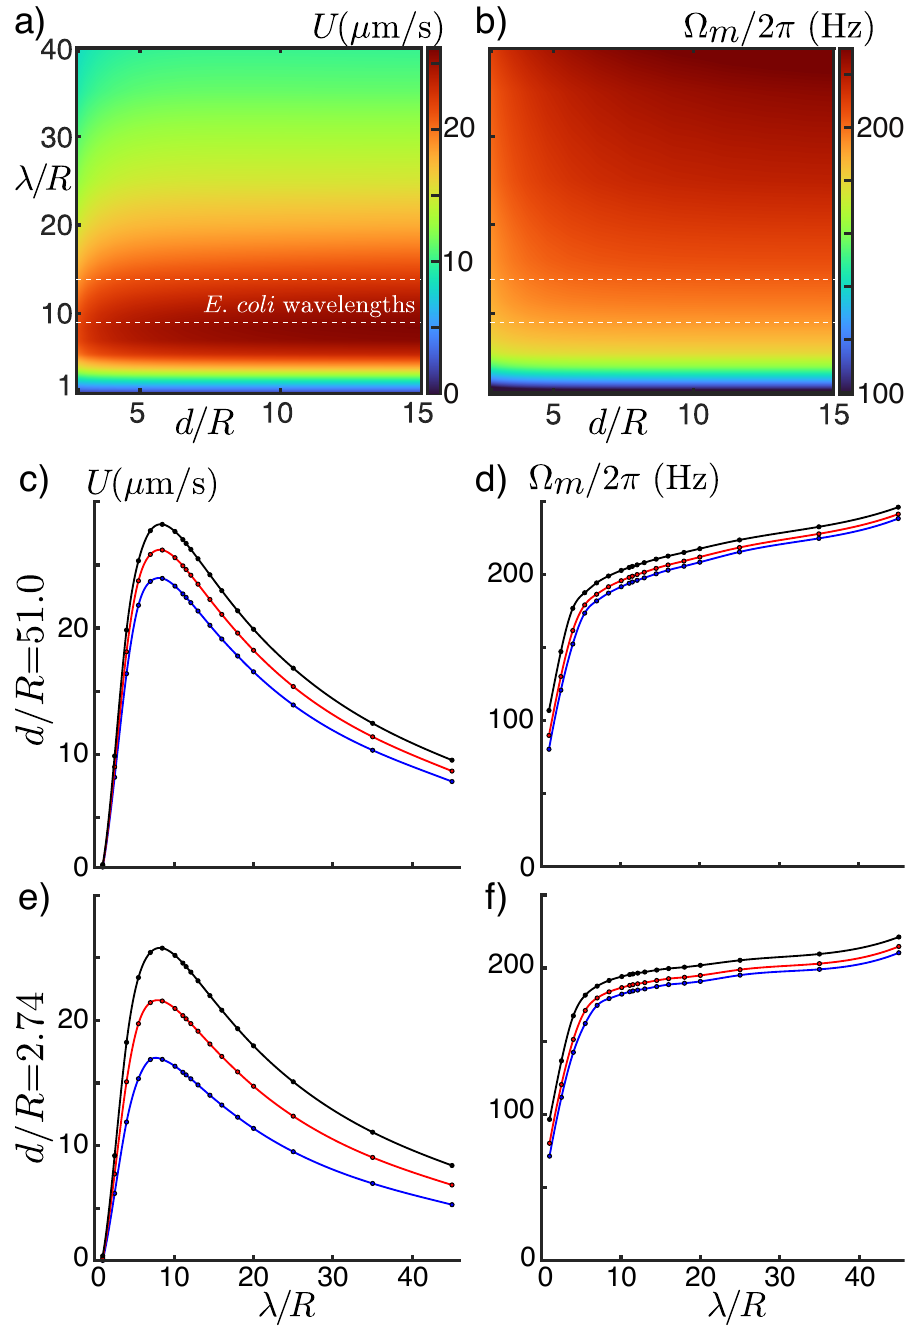
Figure 10. Swimming speed and motor frequency for different flagellar wavelengths at different boundary distances. Panels ( a , b ) show heat maps of free swimming speed U and motor frequency Ω m /2 π with axes flagellar wavelength ( λ / R ) versus boundary distance ( d / R ), where R is the helical radius. Typical E. coli wavelengths are indicated with the dashed white lines, which shows this range is near to the peak in swimming speed. Panels ( c – e ) show line plots of speed and motor frequency across different body sizes far from ( d / R = 51.0) and near ( d / R = 2.74) the boundary. The solid circles are the simulation data points and the solid curves are spline fits to the data. The three curves show the maximum (black), the median (red), and the minimum (blue) among all cell bodies simulated. Panels c and e show that the peak swimming speed λ / R ≈ 8, which is close to the range of E. coli wavelengths, and the peak has a long “tail” as wavelength increases. Panels ( d , f ) show increasing motor frequency with increasing wavelength. The trend reflects the plot of the torque–speed curve in Figure